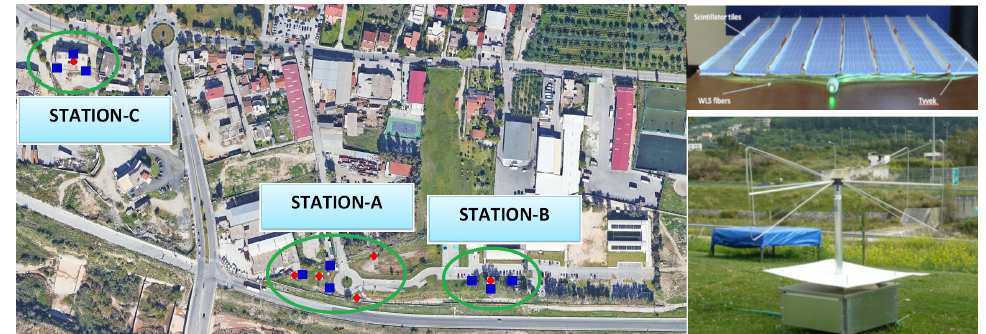
Figure 1. ( Left ) The Astroneu array installed at the Hellenic Open University campus. Helycon Detectors modules are marked with squares, while the RF Antennas with circles. The geodesic coordinates of the stations centers are: Station A (38 ◦ 12 (cid:48) 22.69 (cid:48)(cid:48) N, 21 ◦ 45 (cid:48) 52.60 (cid:48)(cid:48) E), Station B (38 ◦ 12 (cid:48) 22.49 (cid:48)(cid:48) N, 21 ◦ 45 (cid:48) 59.32 (cid:48)(cid:48) E), Station C (38 ◦ 12 (cid:48) 29.62 (cid:48)(cid:48) N, 21 ◦ 45 (cid:48) 42.36 (cid:48)(cid:48) E). ( Right ) On the top photo the internal structure of the HDM is shown. On the bottom photo the Codalema butterfly antenna is shown on the foreground, while the HDM on the